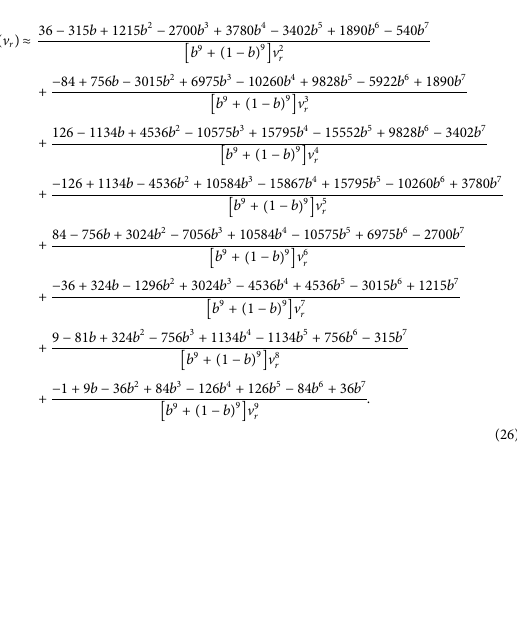
n = 6 equation for helium-4 ( 4 He) ( 9 − χ ) 1 9 For n = 6 with b (cid:1) and a ≈ 1 (19), we have ( 9 − χ ) 1 9 + χ 1 9